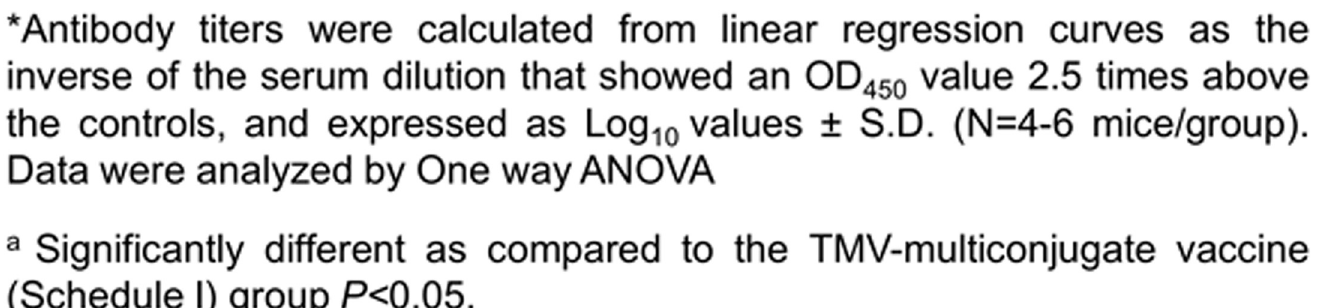
Fig 9. OmpA, DnaK and Tul4 Specific Antibody Responses in Mice Immunized with TMV-Multiconjugate Vaccines using Schedule I and II of Immunization. F . tularensis SchuS4 recombinant proteins OmpA, DnaK and Tul4 specific IgG, antibody levels on day 28 in serum samples of C57BL/6 mice immunized with TMV-multiconjugate vaccine using Schedule II were determined by ELISA. The plates were coated with recombinant F . tularensis SchuS4 proteins. Serum samples obtained from na ï ve mice or those inoculated with TMV alone were used as controls. The data are represented as Mean ± S.D. of absorbance values measured at 450nm. The comparisons are shown with the data obtained from mice immunized with TMV-multiconjugate vaccine using schedule I (shown in Fig 7). Table shows comparison of antibody titers between groups of mice vaccinated with Schedule I and II vaccination regimens.